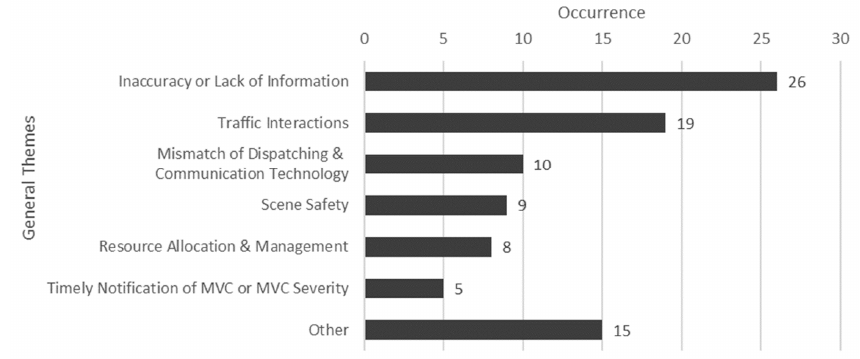
Figure 1. Six themes that the interviewed emergency medical technicians (EMTs) described when addressing the difficulties faced between dispatching, responding to, and leaving the scene of vehicle collisions.